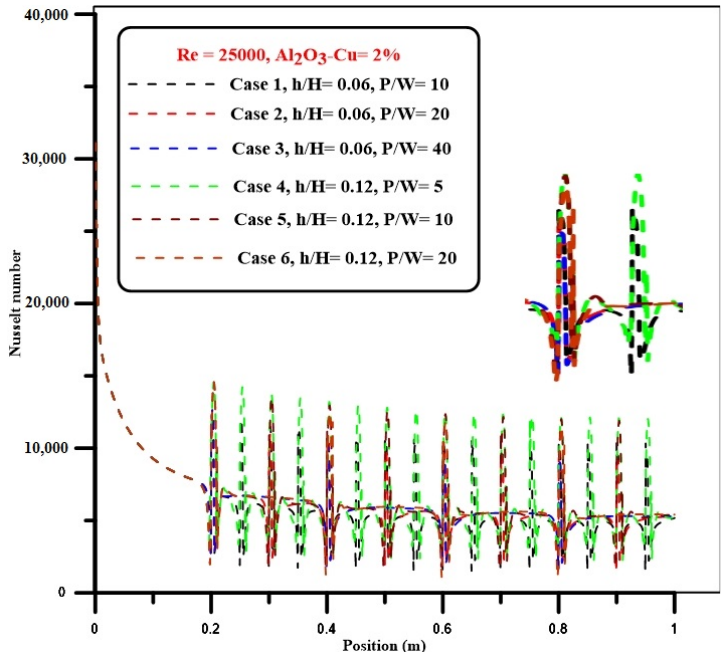
Figure 5. Comparisons between all cases at various step heights and pitch spacing for the ribs at Re = 25,000.